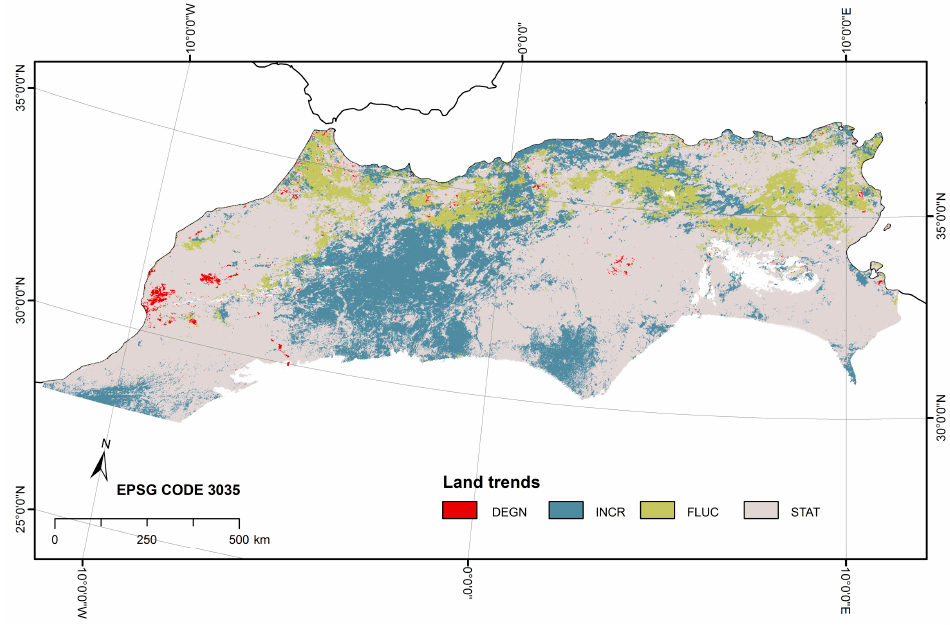
Figure 5. Land condition trends in the NW Maghreb drylands (1998–2008). Legend abbreviations: DEGN: degrading ; INCR: increasing ; FLUC: fluctuating ; STAT: static . EPSG Code 3035: Lambert Azimuthal Equal Area projection, ETRS89 Datum.